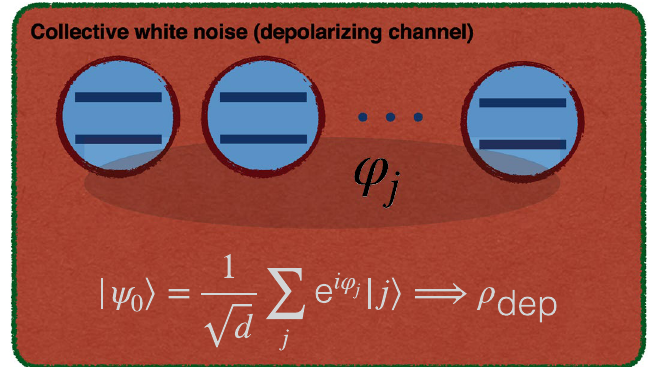
ψ 0 into the mixture | �